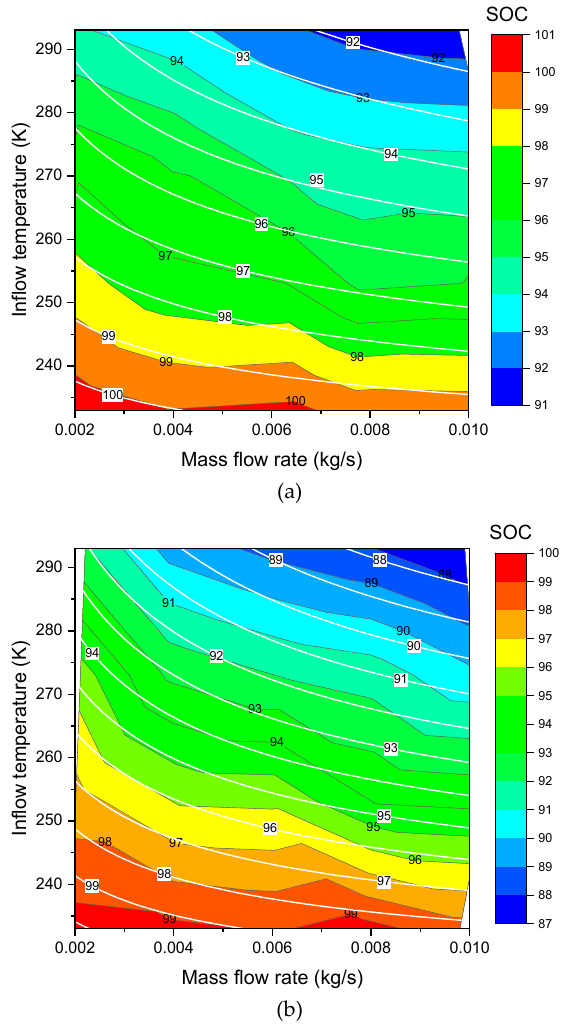
Figure 4. Contours of SOC over mass flow rate (X) and inflow temperature (Y) for ( a ) Type III tank and ( b ) Type IV tank (Color fill and black line: data [14], white line: model fitting). Table 3. Fitted parameters showing effect of both inflow temperature and mass flow rate on SOC. Type III Type IV Parameter Value Standard Error Value Standard Error π